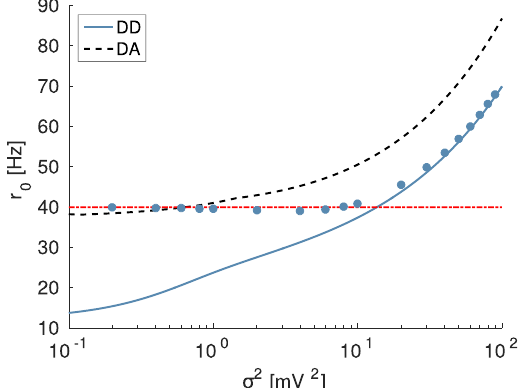
Figure 7. Firing time statistics for exponentially distributed EPSPs and supra-threshold DC current. Firing rate r 0 as a function of noise intensity for excitatory synaptic weights distributed exponentially and a supra-threshold DC current. All parameters as in Fig. 5 except for μ T = μ 0 = 12 mV. The dashed red horizontal line refers to the rate r t of the LIF neuron subject to constant current μ T (Eq. (51)). Other symbols and lines have the same 0 meaning as in Fig. 2, as well as all the other parameters for the IPSP distribution and the numerical